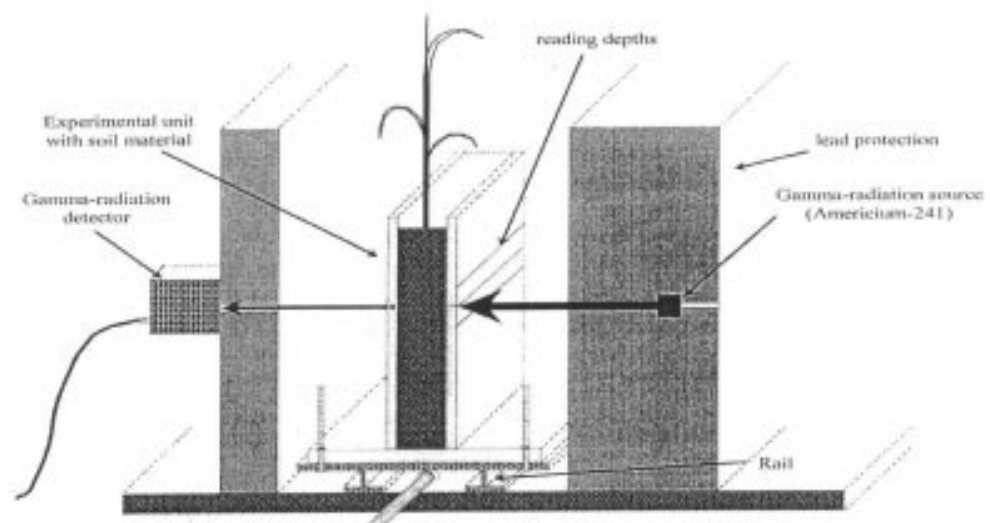
Figure 2. Transversal cut, showing the positioning of the experimental box between source and detector of ggggg